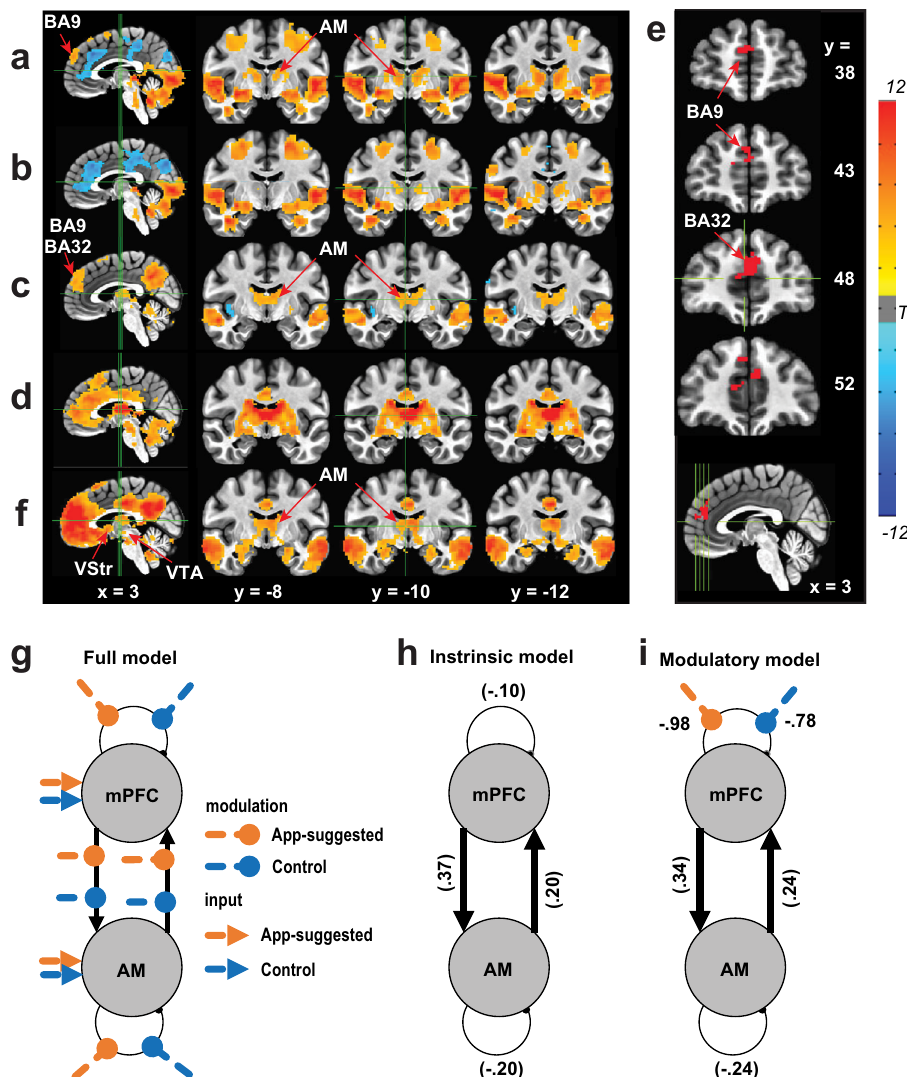
Fig. 8 Reinforcing video clips activate mPFC and ATh at the same time in humans. a Change in BOLD signals upon viewing App-suggested video clips. b Change in BOLD signals upon viewing control clips. c Difference in BOLD signals between app-suggested clips and control clips. d Resting-state functional connectivity map with AM as seed. e Overlapping mPFC zone (BA32 and 9) between c and d . f Resting-state functional connectivity map of the mPFC ( e ) as seed. g Dynamic causal modeling analysis on the mPFC – AM circuit with a full-model structure involving three components consisting of four intrinsic connections, eight experimental modulation on these connections, and four direct inputs from experimental conditions. h Empirical Bayesian